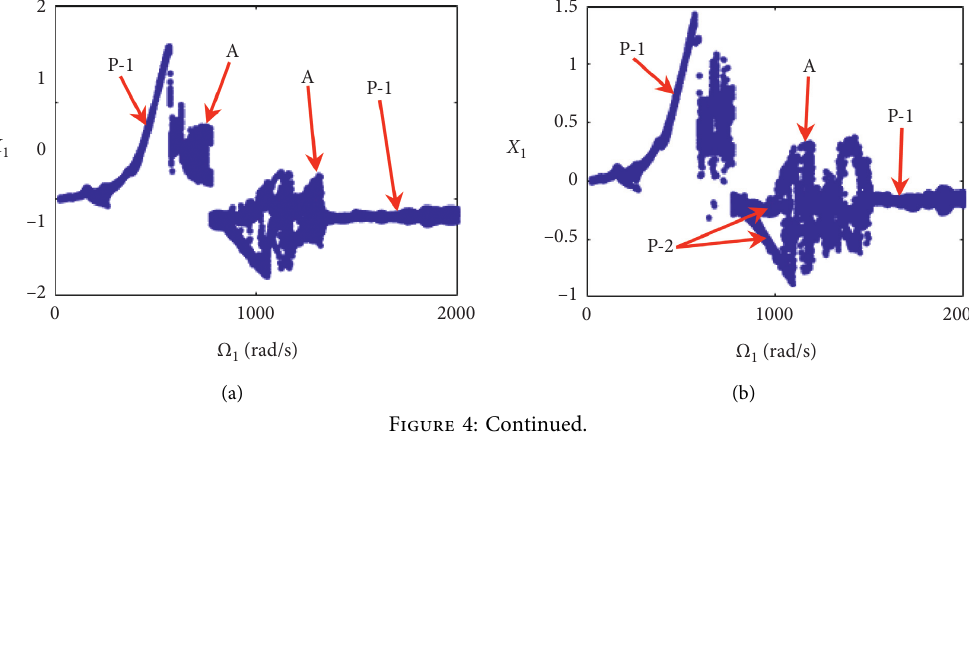
Figure 3: Bifurcation diagrams of the nondimensional displacement in x -direction X c � 10 μ m. The jumping phenomenon occurs in the orange circles; chaotic motion occurs in the green circles. (a) k 0